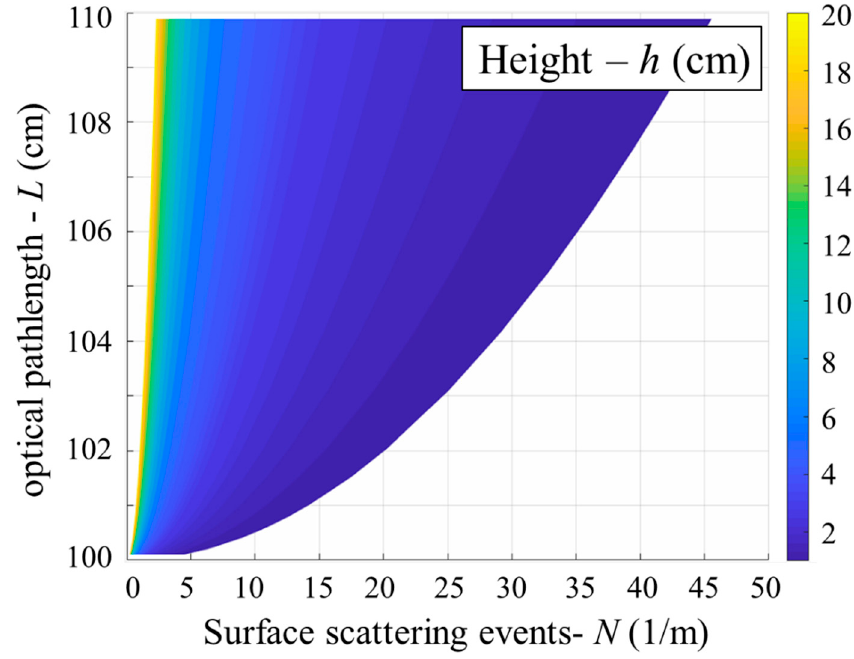
Figure 7. The relationship between the EASSS thickness ( h ) and the optical path length and the number of surface scattering events for light emitted from the focal lines within the EASSS.